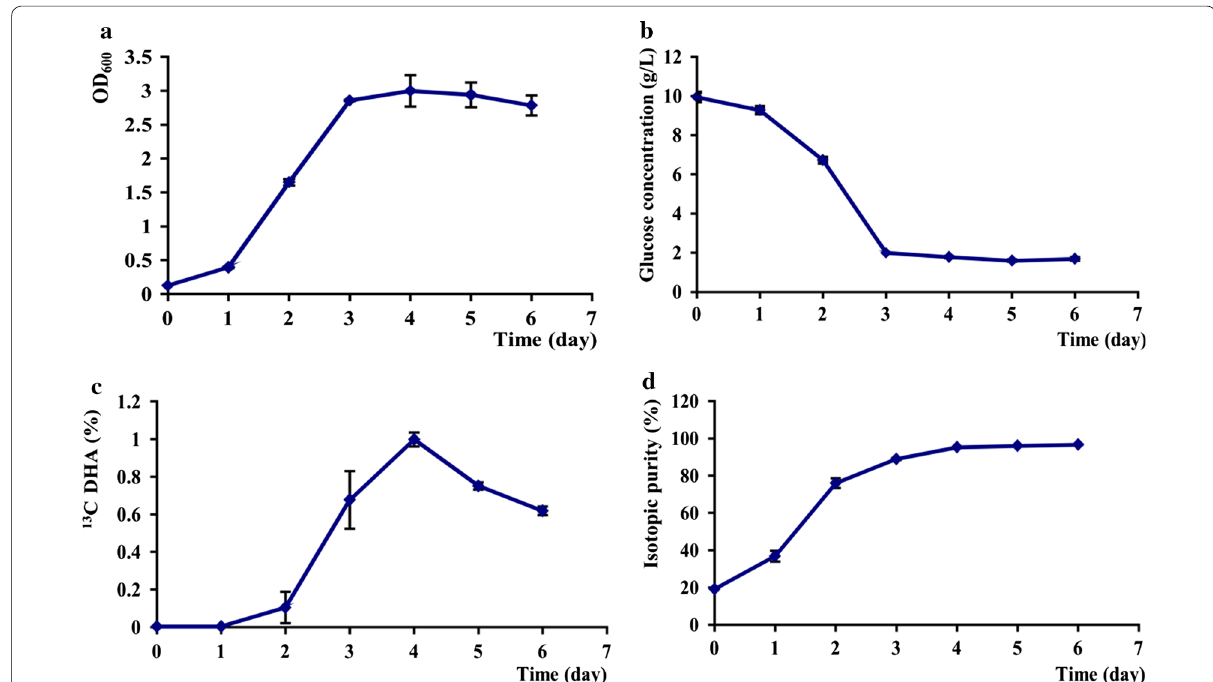
Fig. 1 The growth rate and U- 13 C-DHA production in C. cohnii . a OD 600 ; b glucose consumption; c U- 13 C-DHA yield; d isotopic